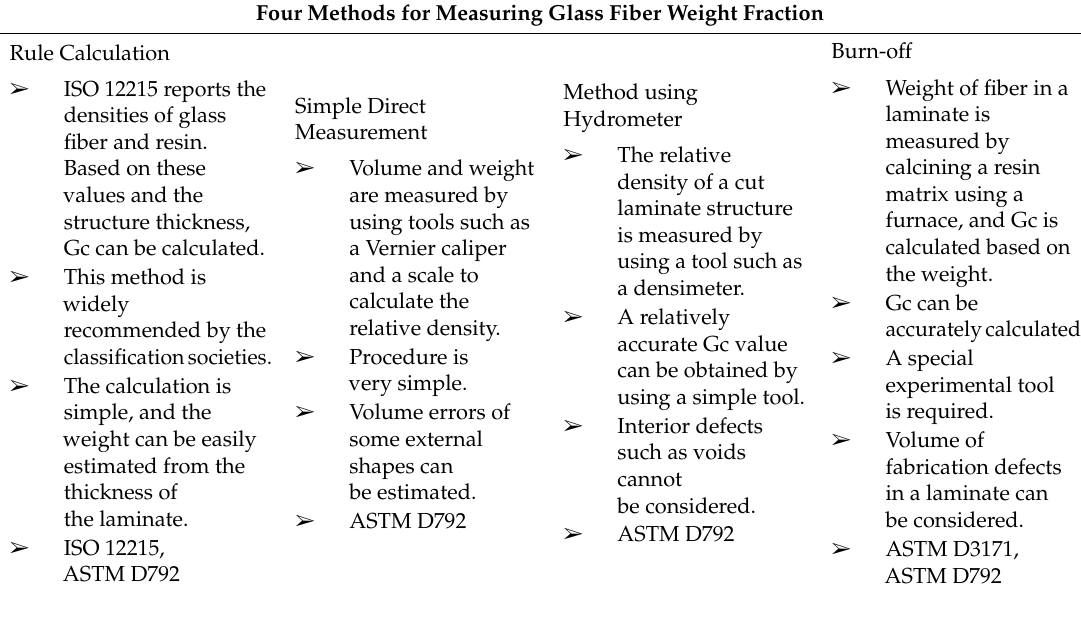
Table 1. Comparison of determination methods for Gc.